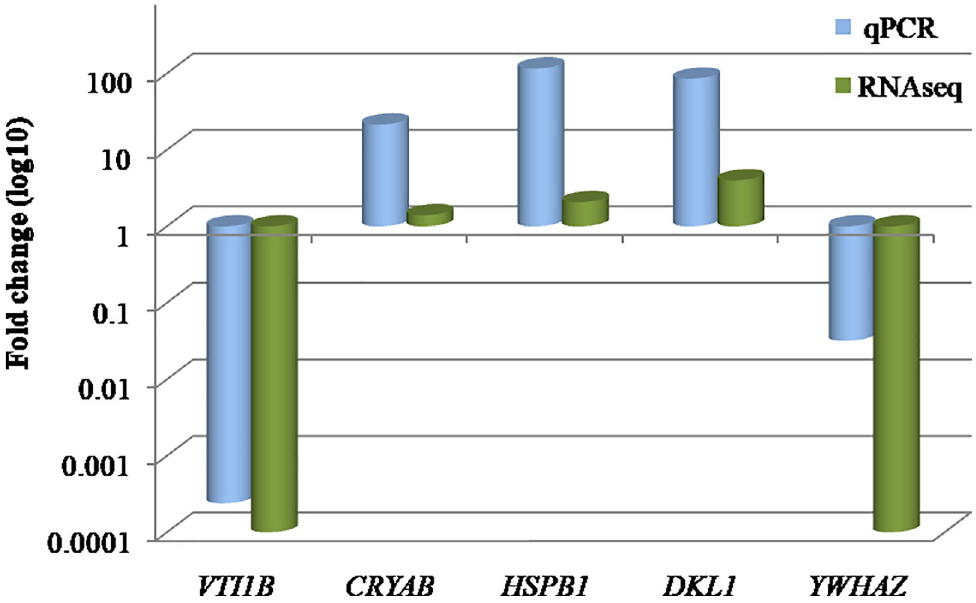
Fig 5. Comparison of fold-change (log 10 ) between RNAseq and qRT-PCR data, for selected genes across Bandur and local sheep. qRT-PCR data was normalized by GAPDH and B2M genes.